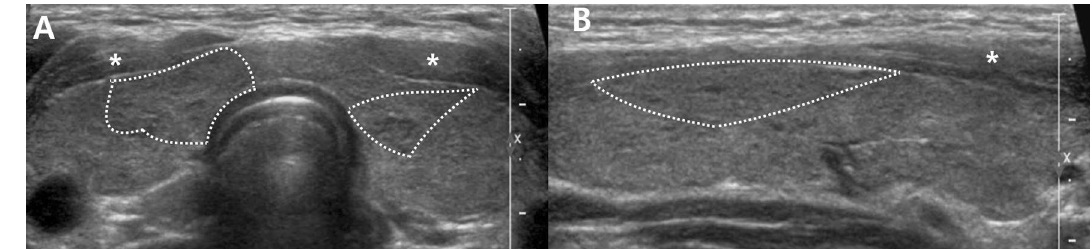
Figure 2. Transverse ( A ) and longitudinal ( B ) US images of G2: diffusely enlarged thyroid gland with heterogeneity involving less than one third of the thyroid gland (area with dashed lines), while the rest of the gland shows normal echogenicity.